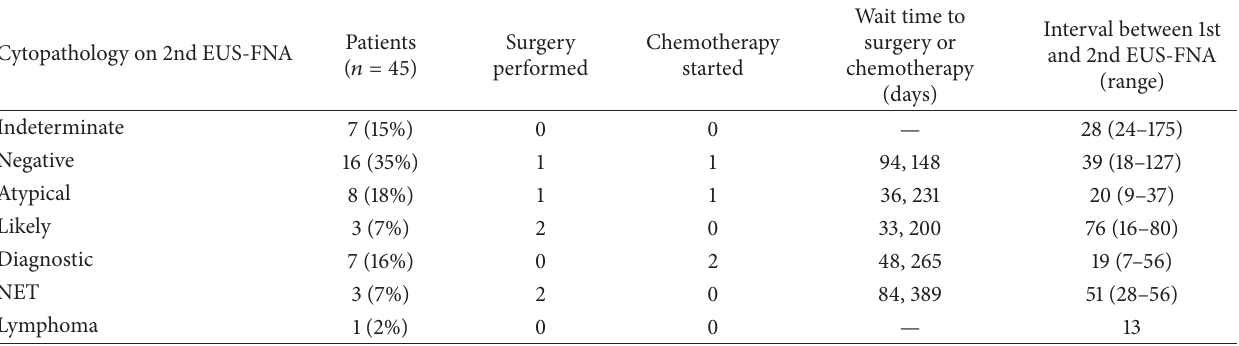
Table 2: Treatment and wait times divided by result of second EUS-FNA in patients who underwent repeat EUS-FNA for diagnosis of suspected pancreatic malignancy at St. Paul’s Hospital, Vancouver, British Columbia, between 2007 and 2014.